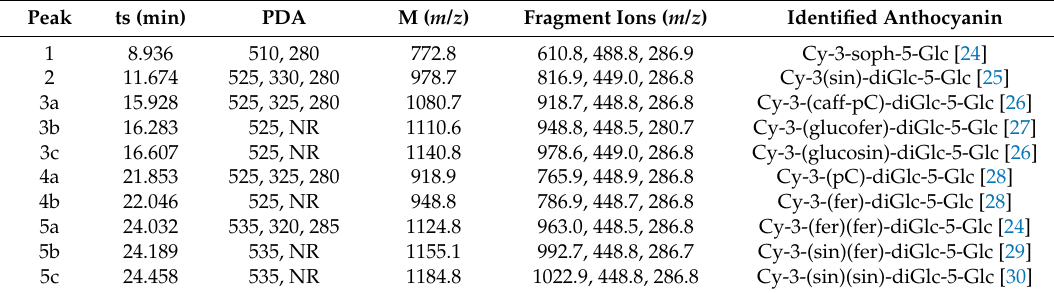
Abbreviations: cyan: cyanidin, soph: sophoroside, Glc: glucoside, sin: sinapoyl, caf: caffeoyl, pC: p-coumaroyl, glucofer: glucopyranosyl-feruloyl, glucosin: glucopyransoyl-sinapoyl, fer: feruloyl. NR